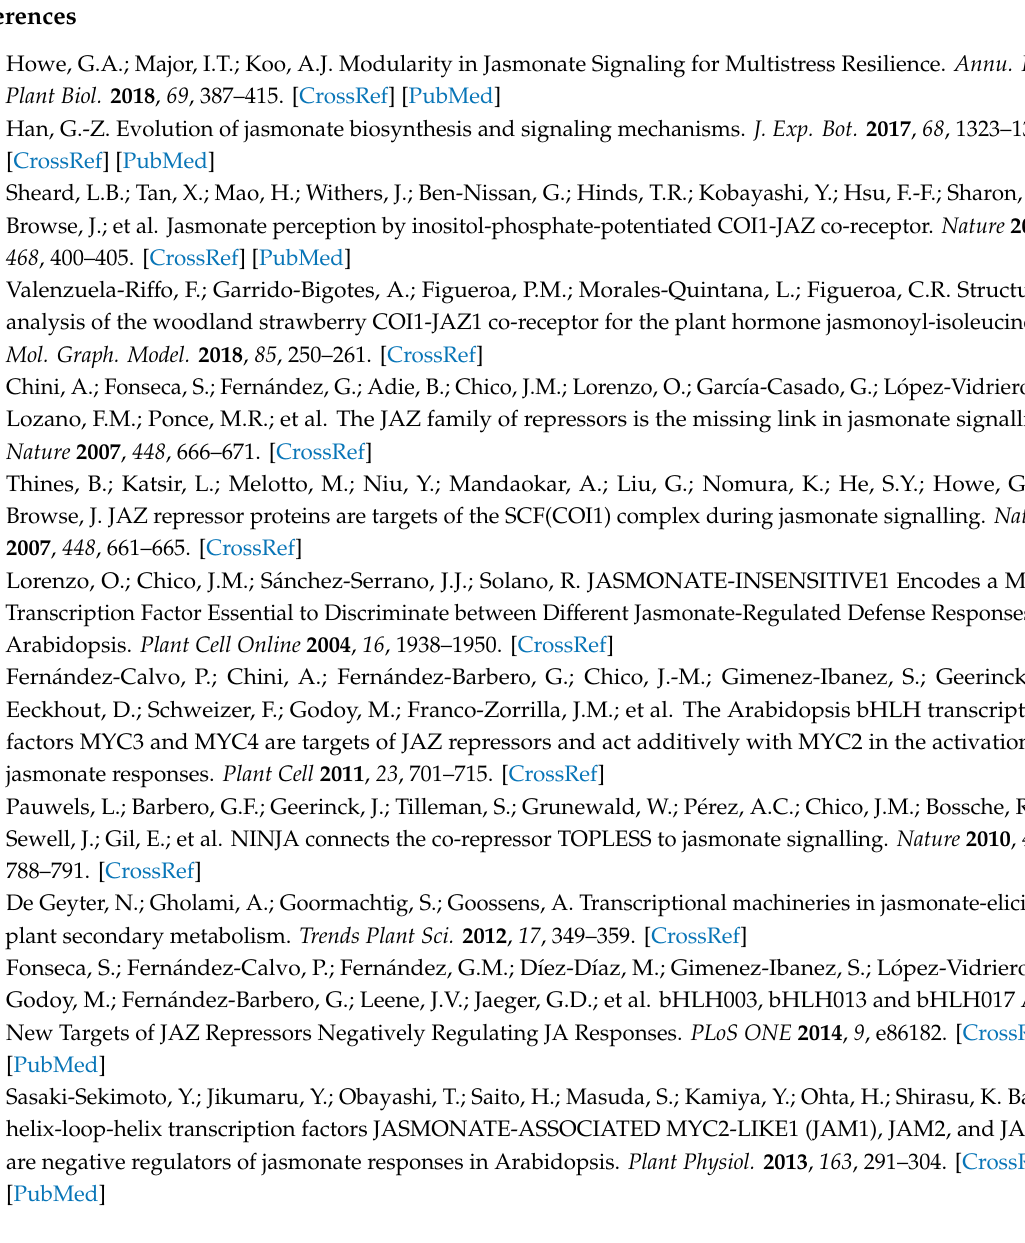
PLAZA database. Table S2. List of specific degron sequences for di ff erent plant lineages. Table S3. List of protein ancestor sequences obtained by PhyloBot